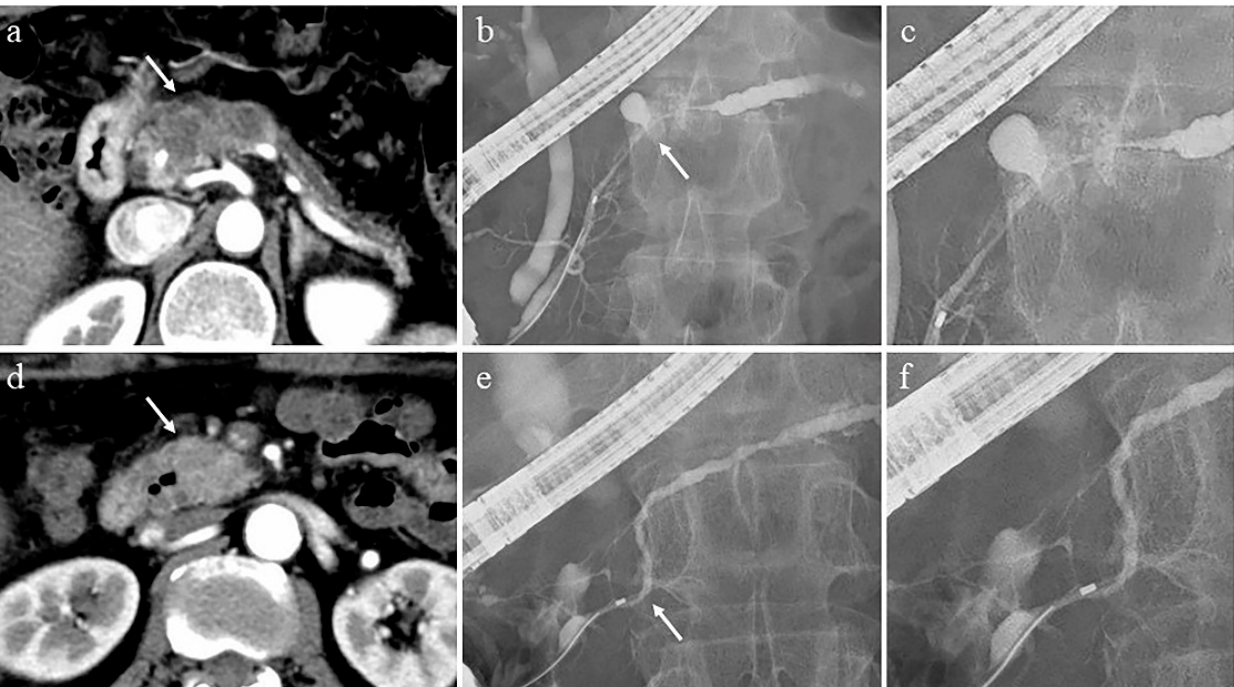
Figure 2. Cases of pancreatic cancer ( a – c ) and autoimmune pancreatitis ( d – f ). ( a ) Computed tomography (CT) shows an irregular and hypovascular 3 cm-seized mass in the pancreatic body (arrow) and dilatation of the upstream main pancreatic duct (MPD). ( b ) Endoscopic retrograde pancreatography (ERP) shows the MPD stricture in the pancreatic body (arrow) and upstream MPD dilatation. ( c ) Deviation of side branches from the stricture site is not observed. ( d ) CT shows a 2 cm-sized mass with hypovascularity in the arterial phase in the pancreatic head (arrow). ( e ) ERP shows mild strictures of the Wirsung and Santorini ducts (arrow), and slight upstream MPD dilatation. ( f ) Deviation of side branches from the stricture site is